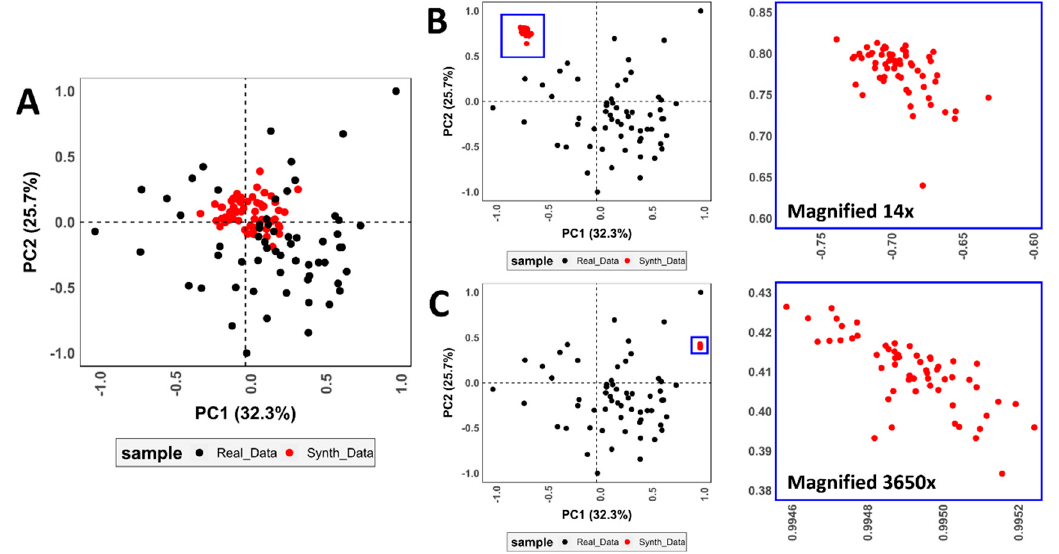
Figure 3. Examples of GAN failure in the form of ( A ) slight, ( B ) large and ( C ) extreme mode collapse when used to augment DS2.